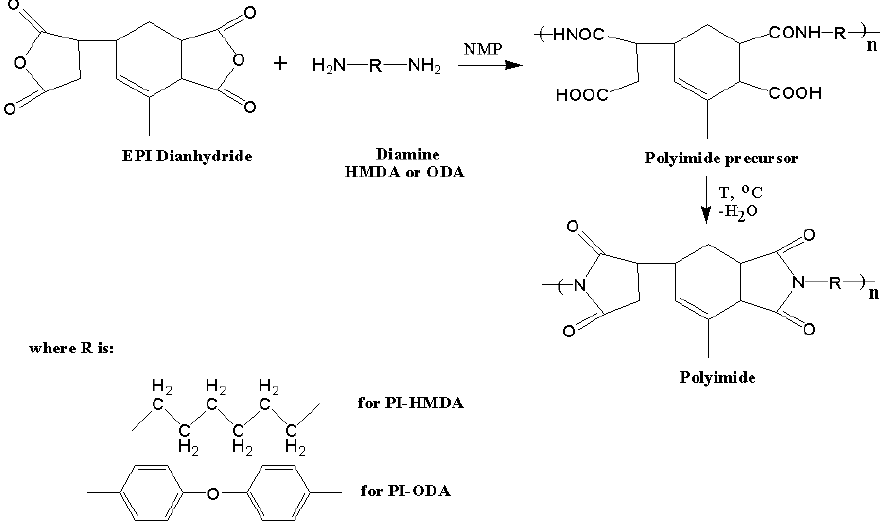
Figure 1. The schematic procedure of synthesis of the EPI-derived